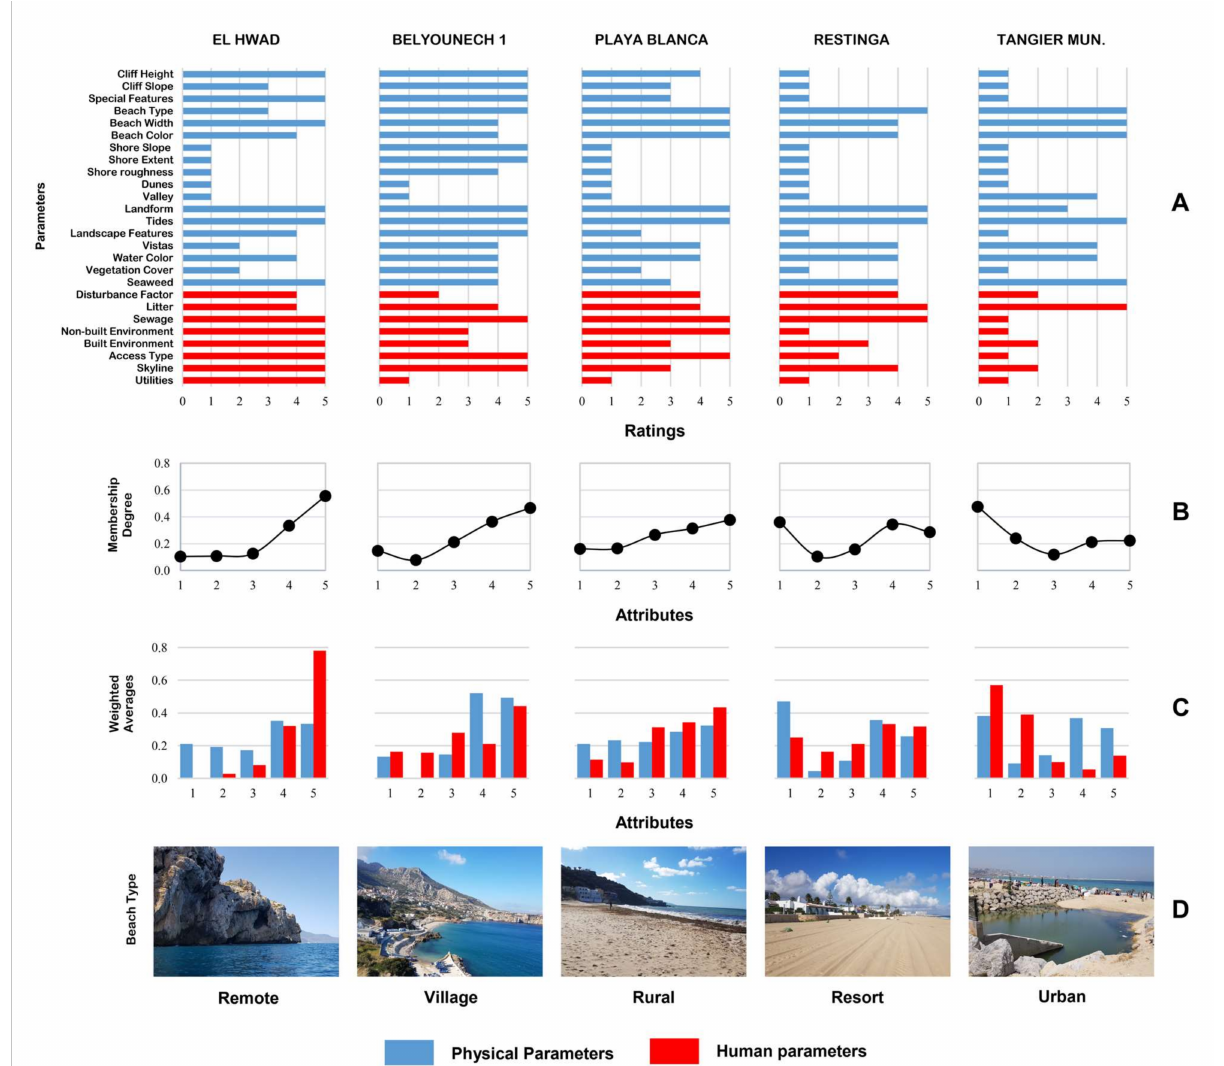
Figure 5. Examples of the site characteristics and status of the physical and human parameters for each class from I to V (left to right), with their respective ( A ) scenic evaluation rating histograms, ( B ) membership degree curve, ( C ) scenic histograms of the weighted averages, and ( D ) beach typol- ogy for El Hwad (Class I, Remote), Belyounech 1 (Class II, Village), Playa Blanca (Class III, Rural), Restinga (Class IV, Re-sort), and Tangier Municipal (Class V,